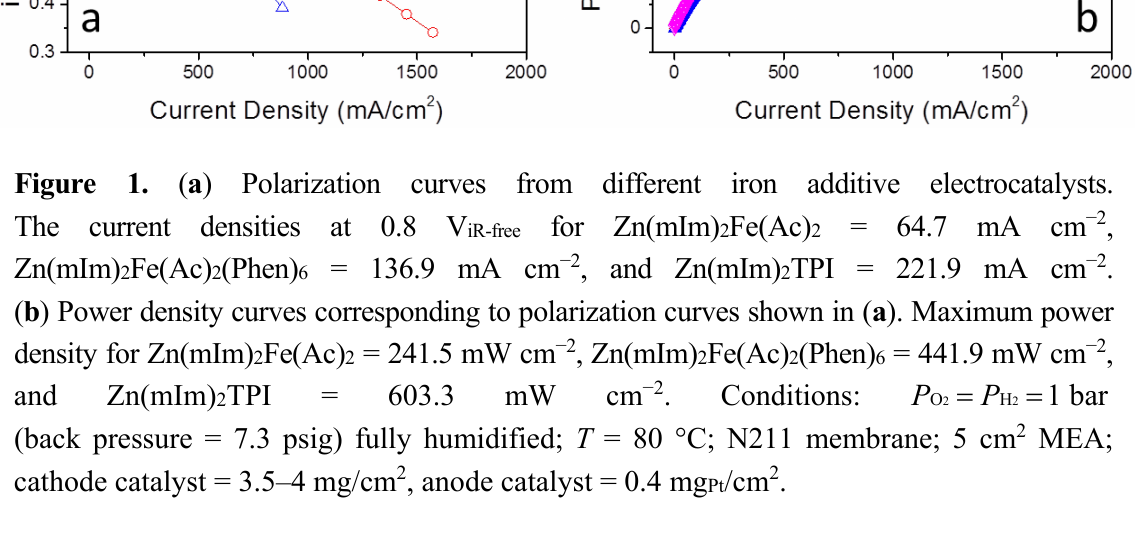
1 bar P P = = 2 2 O H